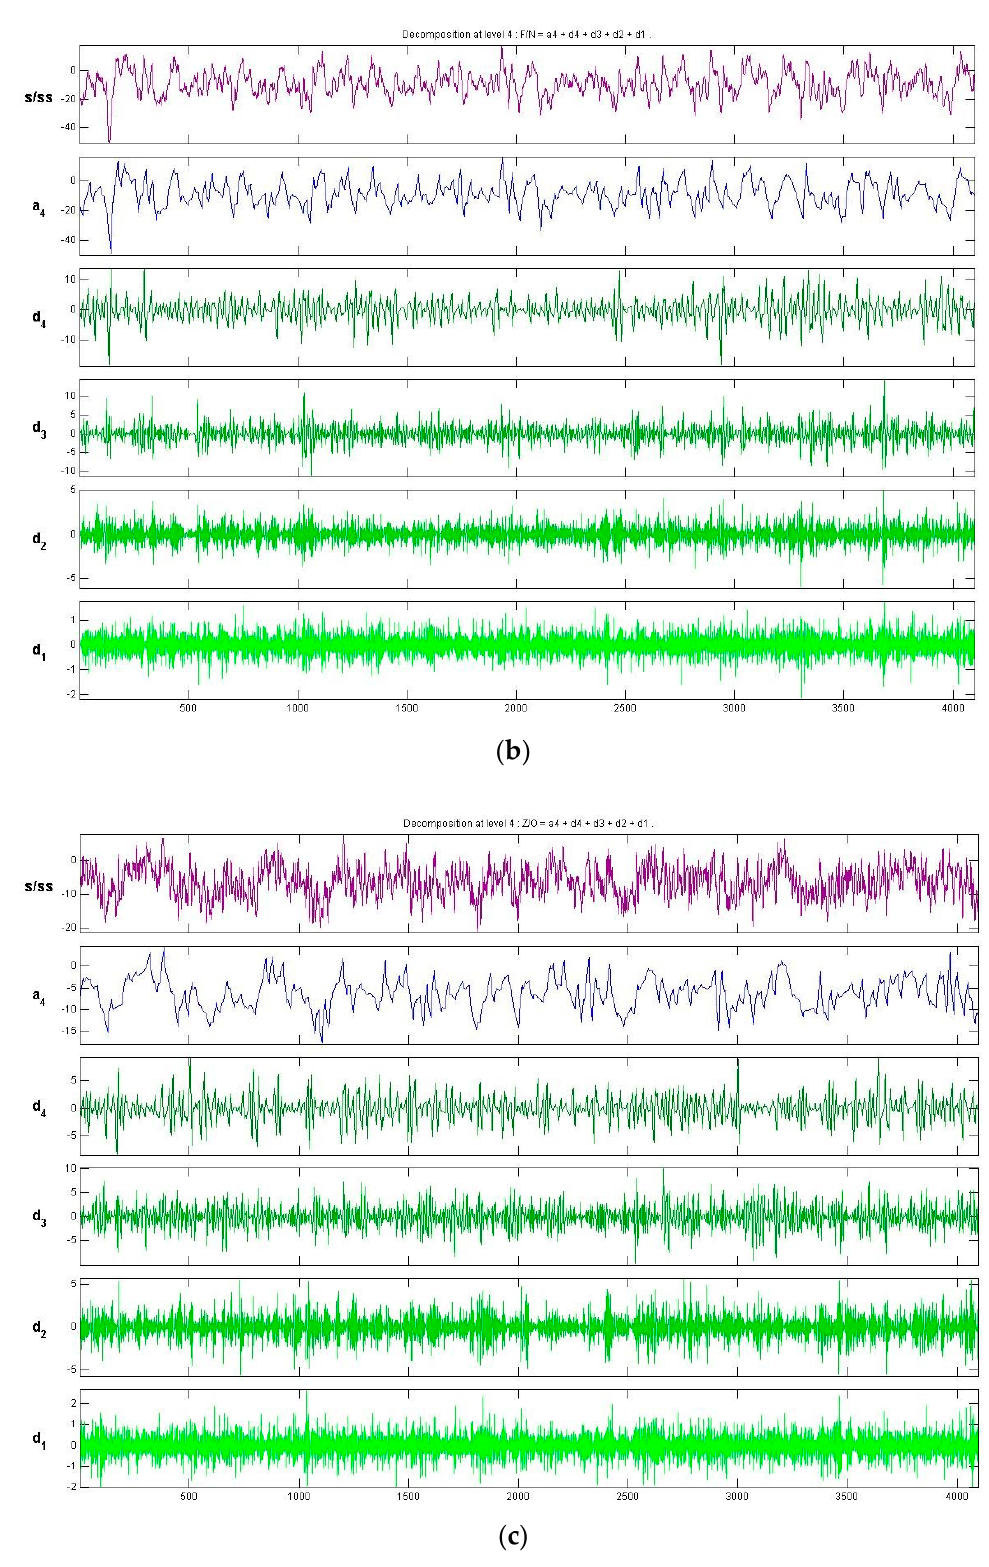
Figure A1. ( a ) Raw {S} data and corresponding wavelet decomposition; ( b ) raw {FN} data and corresponding wavelet decomposition; and ( c ) raw {OZ} data and corresponding wavelet